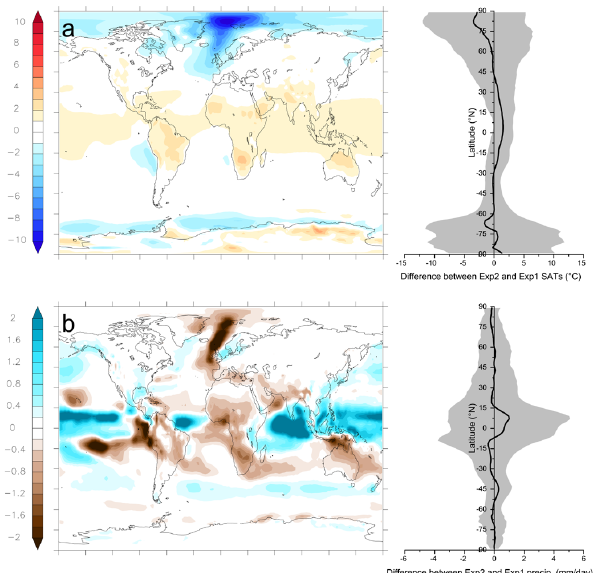
Fig. 4. Difference in multi-model mean anomalies between Experi- ment 2 and 1. (a) difference in mean annual SAT and zonal mean an- nual SAT anomalies. (b) difference in mean annual and zonal mean annual total precipitation rate anomalies. Shading around the mean represents the model 2 σ